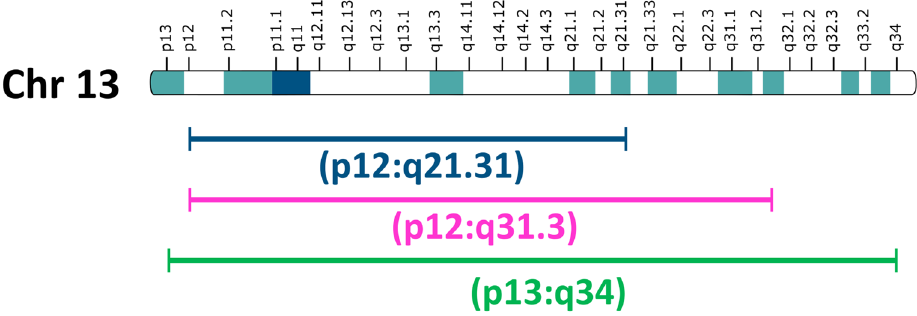
Figure 6. Schematic of chromosome 13 showing an approximate comparison of the length of r(13). The green line represents our patient, and the red and blue lines represent Bershteyn’s 21 patients (Inkscape (v.0.91) (https :// inksc